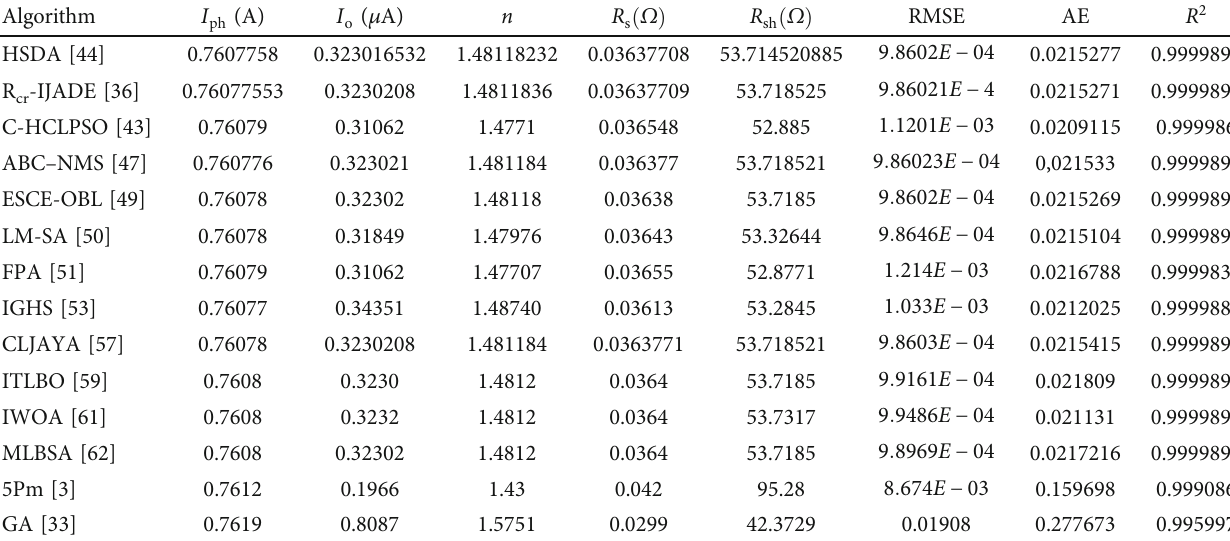
Figure 2: HSDA algorithm fl ow chart [44]. Table 3: The parameters and statistical tests for RTC